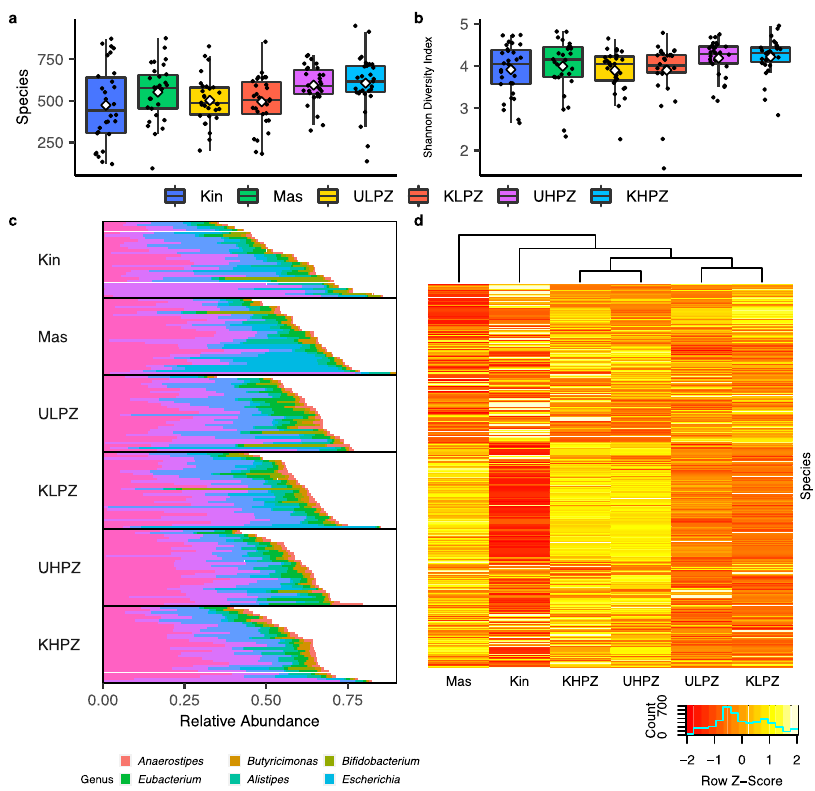
Fig. 2 Overall alpha diversity and bacterial distribution in study groups. Microbiome composition for all study groups that include a species level assignments post fi ltering to include those bacteria whose relative abundance ≥ 0.01% in each of the 180 participants from Kinshasa (Kin) ( n = 30, mean = 473.2), Masi-Manimba (Mas) ( n = 30, mean = 552.1), Unaffected Low Prevalence Zone (ULPZ) ( n = 30, mean = 502.4), Konzo Low Prevalence Zone (KLPZ) ( n = 30, mean = 494.3), Unaffected High Prevalence Zone (UHPZ) ( n = 30, mean = 594.5), and Konzo High Prevalence Zone (KHPZ) ( n = 30, mean = 606.2). b Shannon Index measures post fi ltering that includes species in each participant that had a relative abundance ≥ 0.01 from Kinshasa ( n = 30, mean = 3.918), Masi-Manimba ( n = 30, mean = 3.996), ULPZ ( n = 30, mean = 3.897), KLPZ ( n = 30, mean = 3.9), UHPZ ( n = 30, mean = 4.186), and KHPZ ( n = 30, mean = 4.217). c Highly abundant genus level assignments in the study groups (standard deviation for genus measures can be found in Supplementary File 2). d Z-score Heat map representation of the average relative abundances of the 694 species that passed the ≥ 0.01% relative abundance in either of the six study groups. In a and b , data are represented as boxplots where the diamond denotes the mean, middle line in the box is the median, the lower hinge is the fi rst quartile, the upper hinge is the third quartile, and the whiskers extend from the lower and upper hinges to the smallest and largest value, respectively, at most to 1.5 * IQR (IQR, interquartile range, is the distance between the fi rst and third quartile), with each individual value Masi-Manimba (Fig. 3b), Kinshasa vs. unaffected children in the LPZ (Fig. 3c) or Kinshasa vs. unaffected children in the HPZ (Fig. 3d), strong segregation remains, with varying degrees of sta- tistical signi fi cance (PERMANOVA p = 2 × 10 − 5 , p = 0.00139, p = 1 × 10 − 5 , respectively). Interestingly, these global differences extend beyond urban versus rural, as seen when comparing the genus level gut fl ora pro fi les of children from rural Masi-Manimba to the unaffected children of the Kahemba LPZ (PERMANOVA p = 3 × 10 − 5 ) (Fig. 3e) and HPZ (PERMANOVA p = 0.00321) (Fig. 3f). When assessing speci fi c differences in relative abundance at the genus level, we fi nd that compared to Kinshasa, the unaf- fected children of the Kahemba HPZ harbors the most signi fi cantly different genera at 285, followed by Masi-Manimba with 215, while 137 genera were signi fi cantly different when compared to unaf- fected children in the Kahemba LPZ (expected BH-corrected p - value < 0.01, Wilcoxon test, ALDEx2) (Supplementary Data 3). To